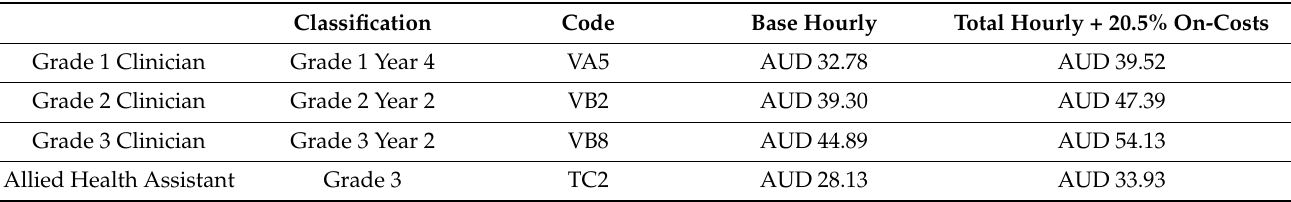
Table 1. Key classifications for the health service salary calculator.